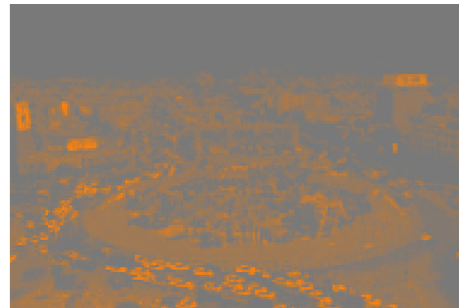
Figure 8: Image with coe ffi cient I .